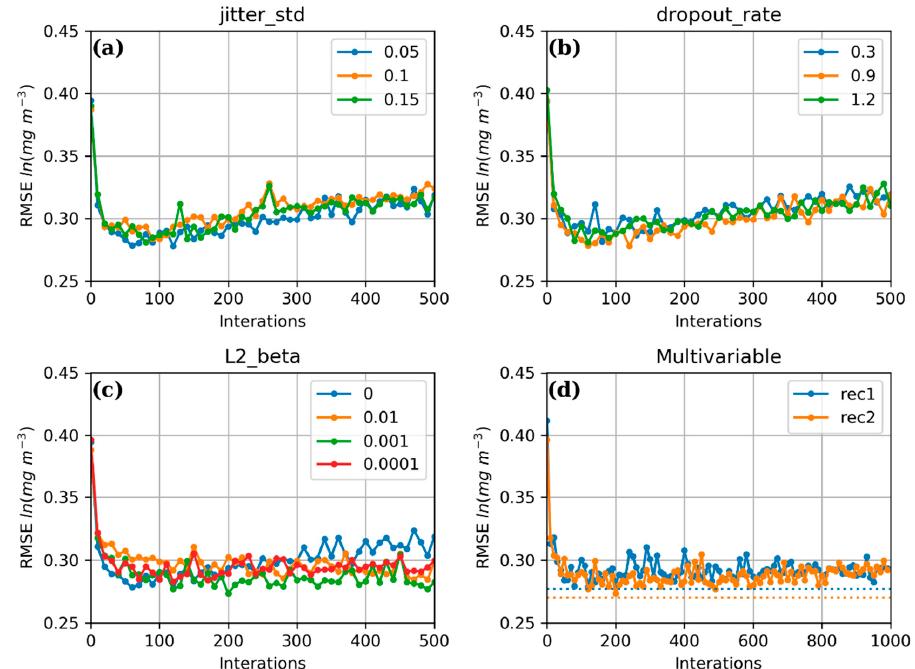
Figure 7. Cross-validation errors as a function of iteration for the DINCAE experiments. ( a ) The optimal jitter_std in rec2 chosen from (0.05, 0.10, 0.15) based on dropout_rate = 0.3 and L 2_beta = 0; ( b ) the optimal dropout_rate in rec2 chosen from (0.3, 0.9, 1.2) based on jitter_std = 0.05 and L 2_beta = 0; ( c ) the optimal L 2_beta in rec2 chosen from (0, 0.01, 0.001, 0.0001) based on jitter_std = 0.05 and dropout_rate = 0.9; ( d ) comparison of the expected errors between rec1 and rec2 using the parameters that jitter_std = 0.05, dropout_rate = 0.9, and L 2_beta = 0.001, and the dotted lines are the RMSE values of the CV-data and the averaged outputs of DINCAE between epoch 200 and epoch